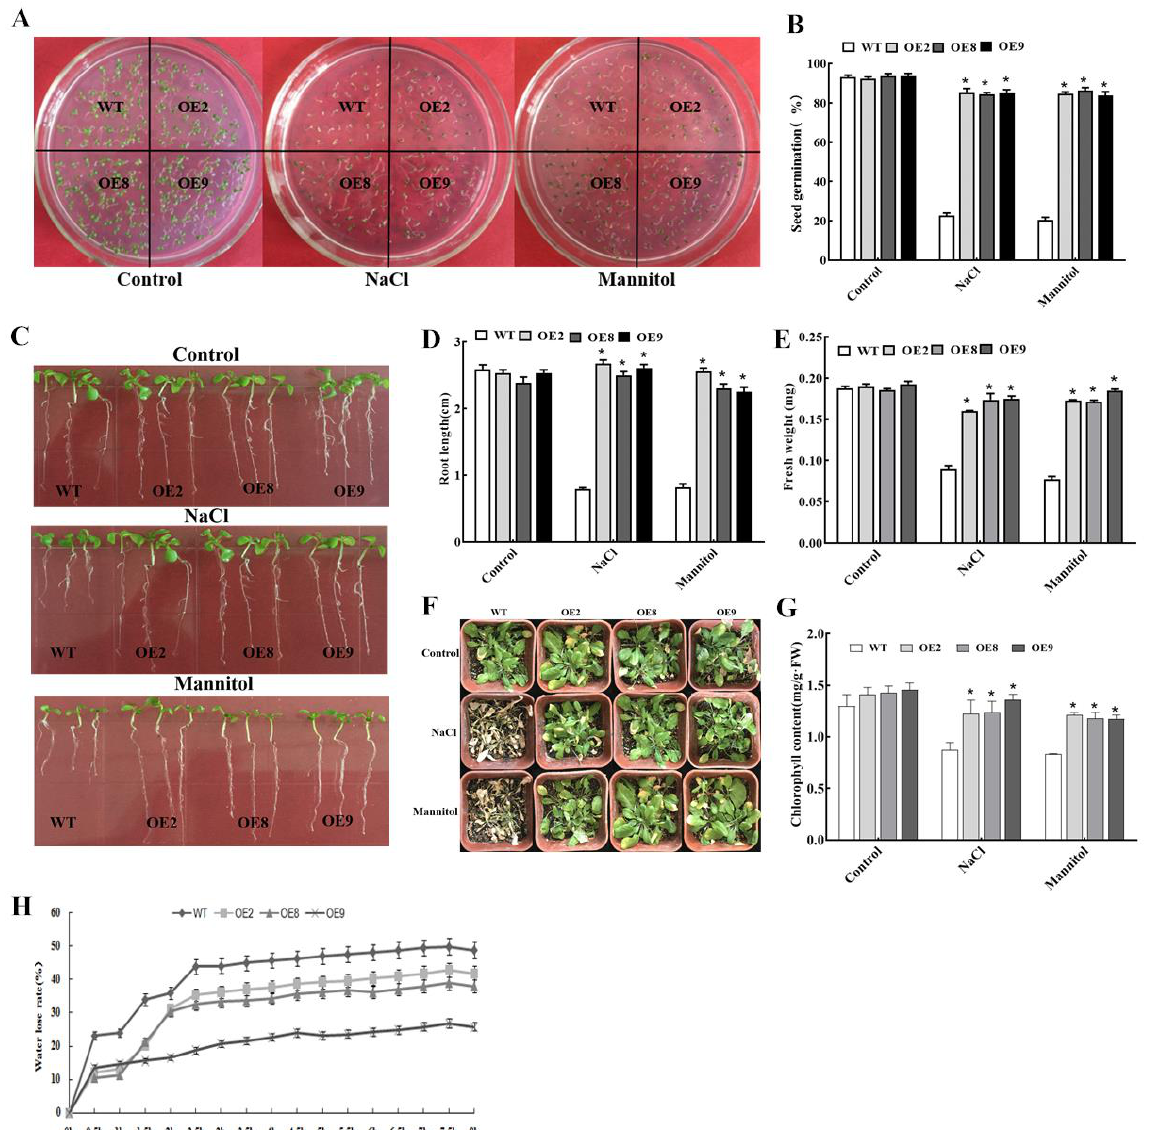
Figure 3. Stress tolerance of Arabidopsis overexpressing ThNAC4 . ( A , B ) Seed germination assay of transgenic (OE2, OE8 and OE9) and wild-type (WT) Arabidopsis plants. Seeds were sown on 1/2 MS solid medium containing 150 mM NaCl or 200 mM mannitol and incubated at 22 ◦ C for 7 days. Photographs were taken, and the germination rates were measured. ( C – E ) Effects of salt and drought stresses on root length and fresh weight. Seven-day-old seedlings were grown on 1/2 MS solid medium containing 150 mM NaCl or 200 mM mannitol for 7 days. Photographs were taken, and the root length and fresh weight were measured. ( F ) Growth phenotype of transgenic and WT Arabidopsis plants. ( G , H ) Effects of salt and drought stress treatment on chlorophyll content and water loss. Three-week-old seedlings in soil were treated with 150 mM NaCl or 200 mM mannitol for one week. Photographs were taken, and the chlorophyll content and water loss were measured. The error bars represent the standard deviations of the mean measurements, which were calculated from three independent experiments. * indicates a significant difference ( p < 0.05) between transgenic lines and WT